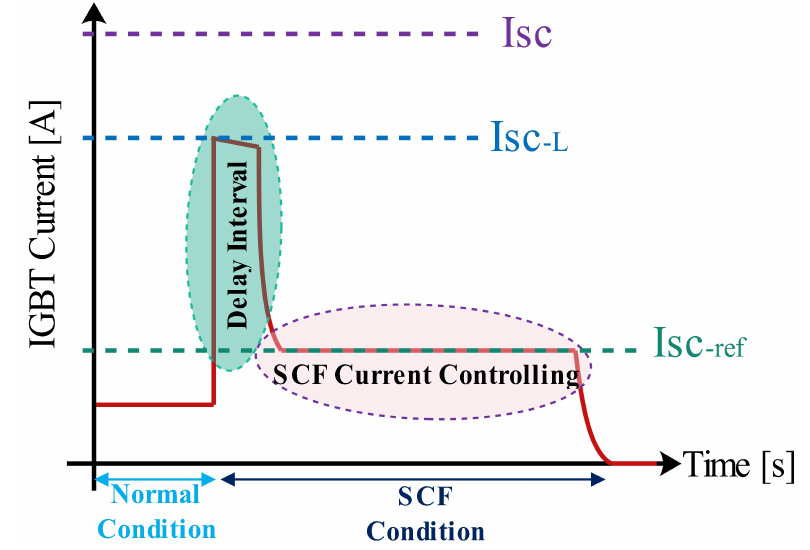
Figure 4. The control signals of the proposed method in normal and SCF conditions.